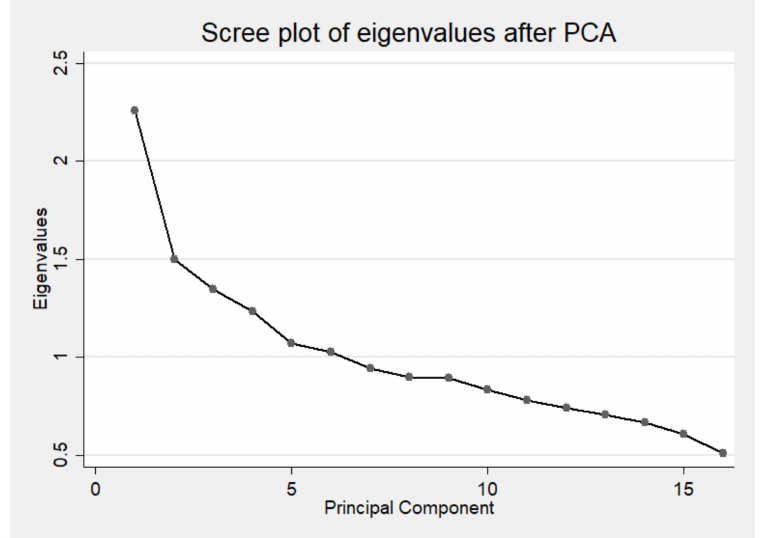
Figure 1. Scree plot from principal components analysis (PCA) of Planetary Health Diet